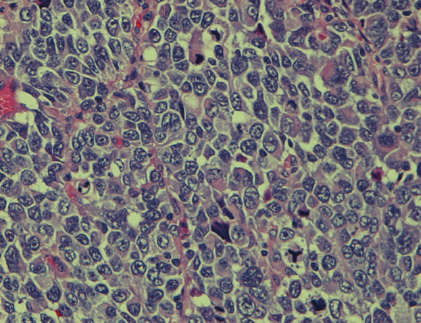
Figure 1: Colonoscopy showing a 4 × 4 cm villous, fungating, nonobstructing, noncircumferential, and nonbleeding mass in the sigmoid colon.